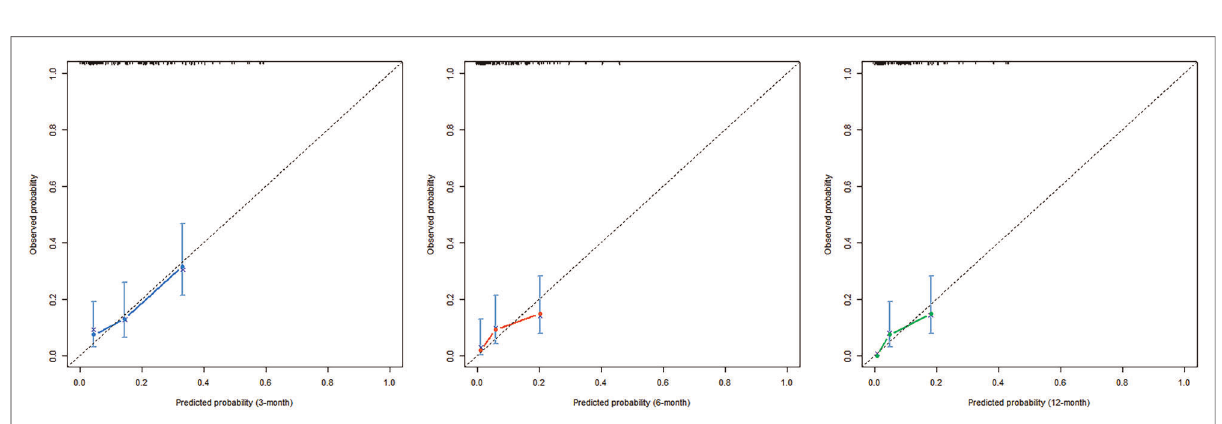
FIGURE 7 Calibration curves of the nomogram. The x-axis shows the predicted probability of PAU, and the y-axis shows the observed probability of